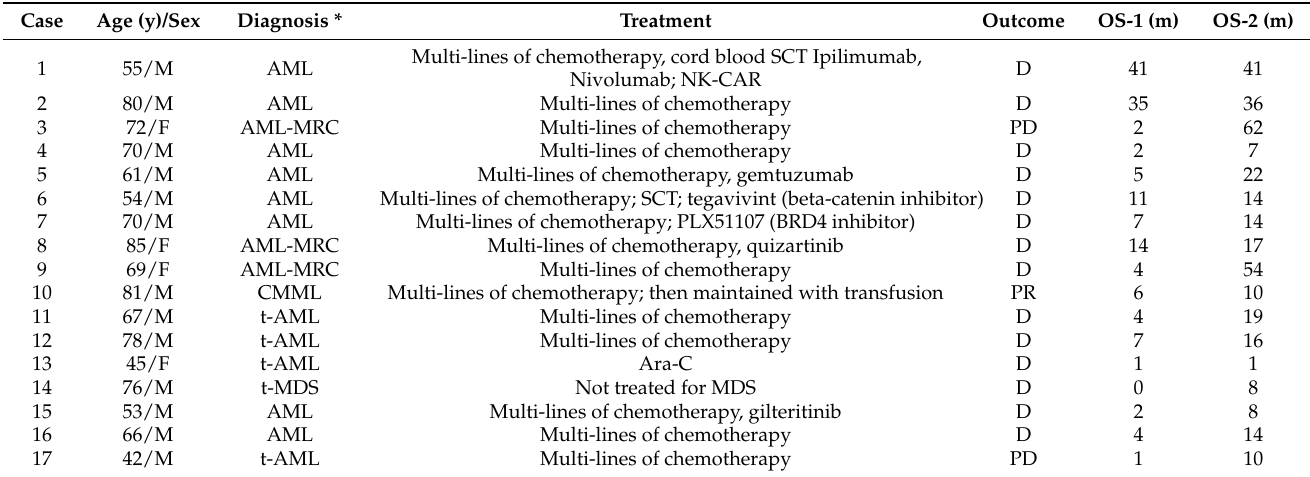
Table 1. Demographic and Clinical